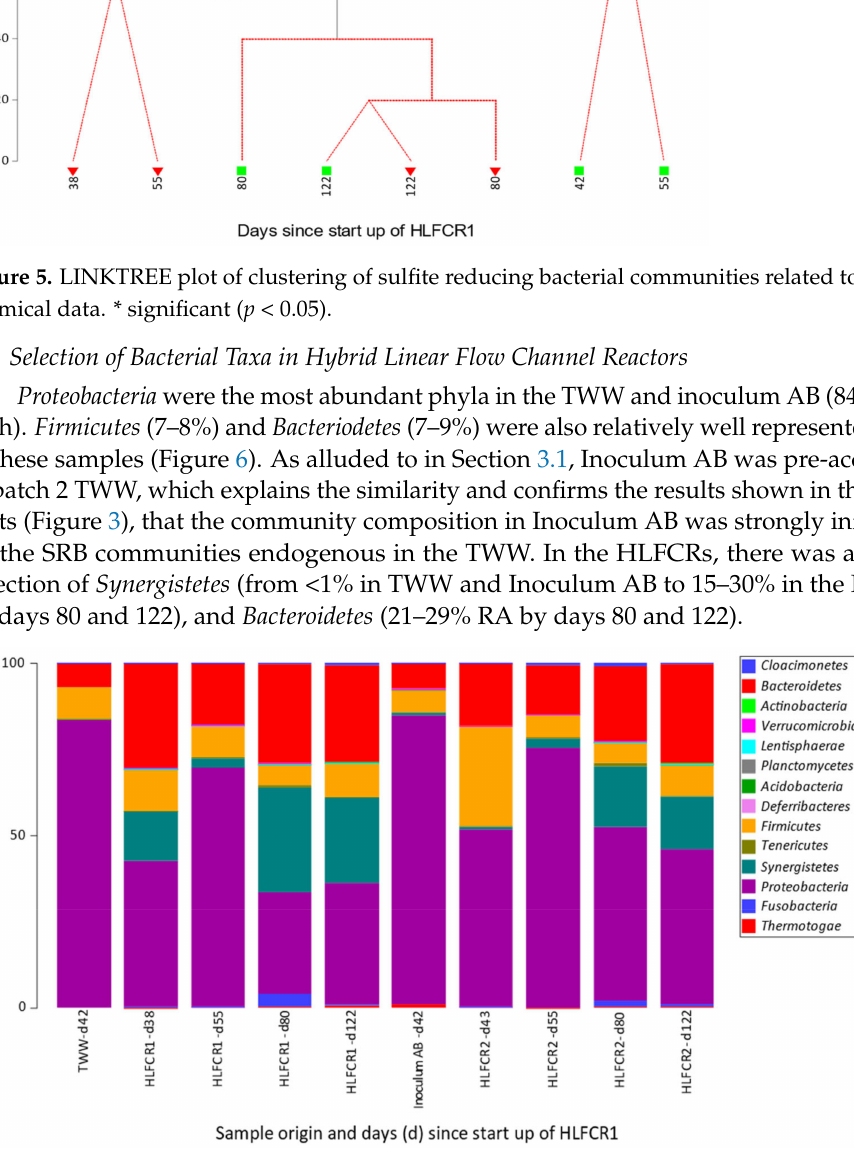
Figure 6. Bar graph of the phyla identified using 16S rRNA amplicon